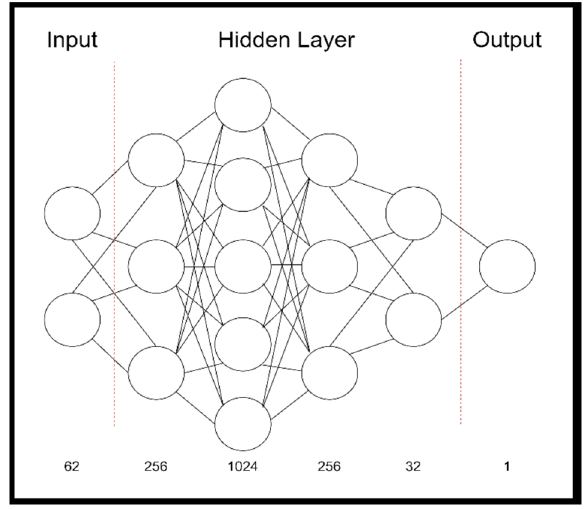
Figure 1. Simple schematic display of the deep neuronal network utilized.